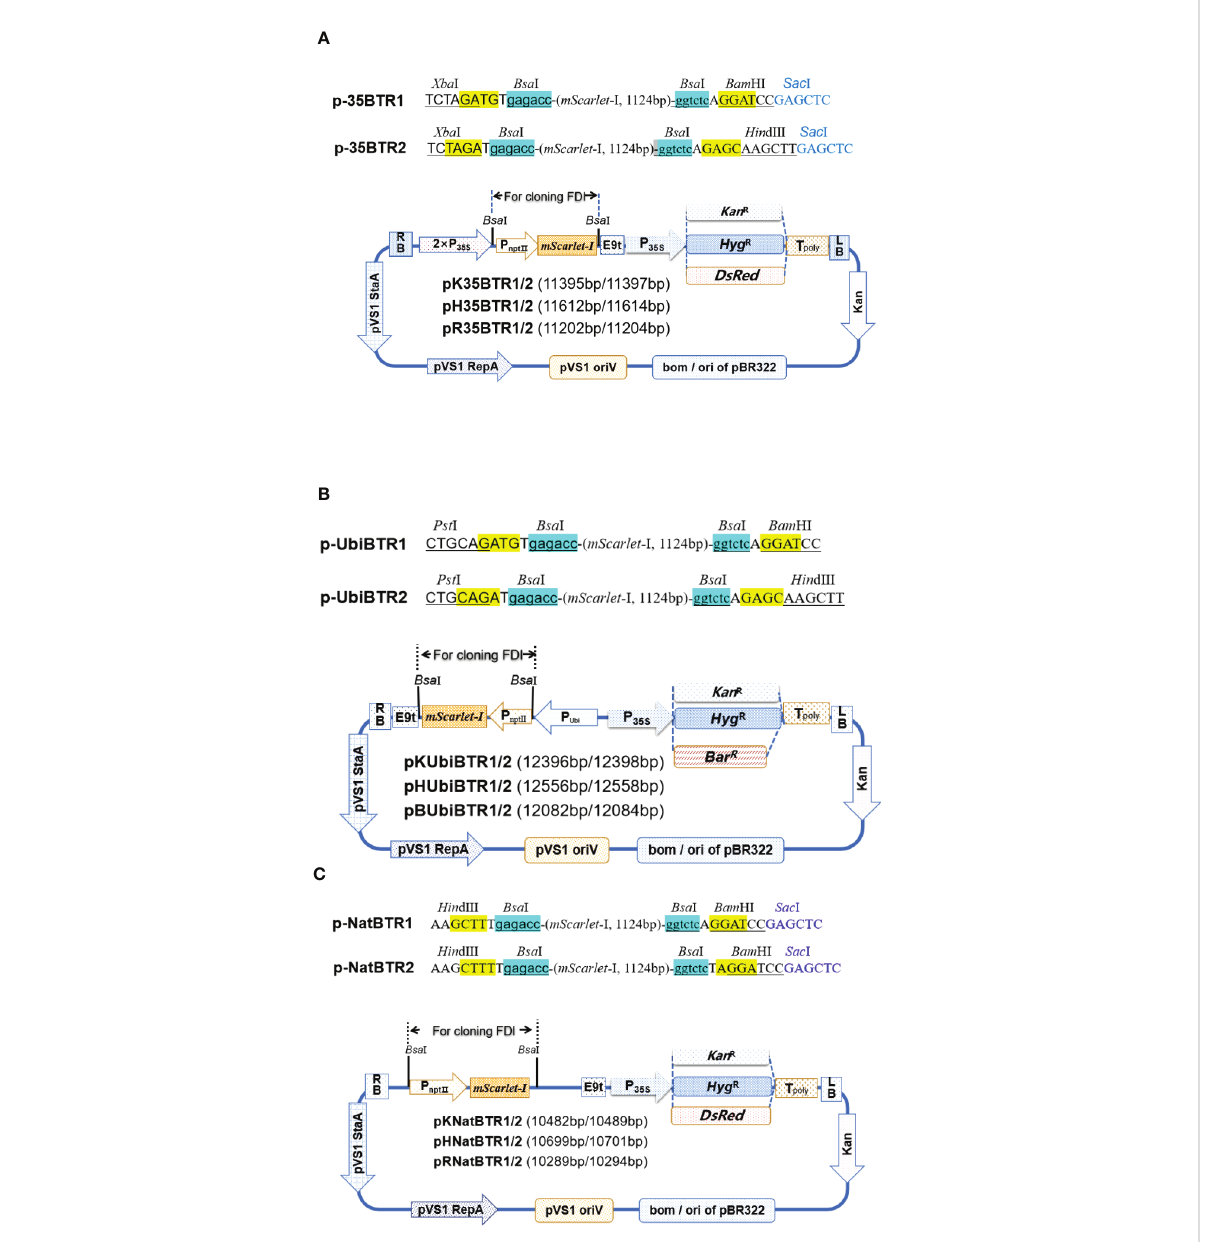
FIGURE 1 Diagrams of (over)expression vectors. Gene (over) expression vectors driven by CaMV 35S based on the pHSE401/pKSE401 backbone (A) . Ubiquitin promoter based on the pYLCRISPR/Cas9Pubi-series of vectors backbone (B) . Native promoter based on the pHSE401/pKSE401 backbone (C) . Kan R , kanamycin resistance gene; Hyg R , hygromycin resistance gene; Bar R , basta resistance gene. The p Npt Ⅱ :: m Scarlet -I expression cassette was used for a visual selection marker in E coli . The two Bsa I recognition sites and neighbor sequences designed for cloning FDI are shown at the top of the vectors. The key restriction sites for further screening of positive recombinants are given. The Kan R , Hyg R , DsRed , and Bar R genes driven by CaMV 35S were used as selection markers/reporters in plant. 5 ’ overhangs (sticky end) produced after digestion by Bsa I are highlighted in